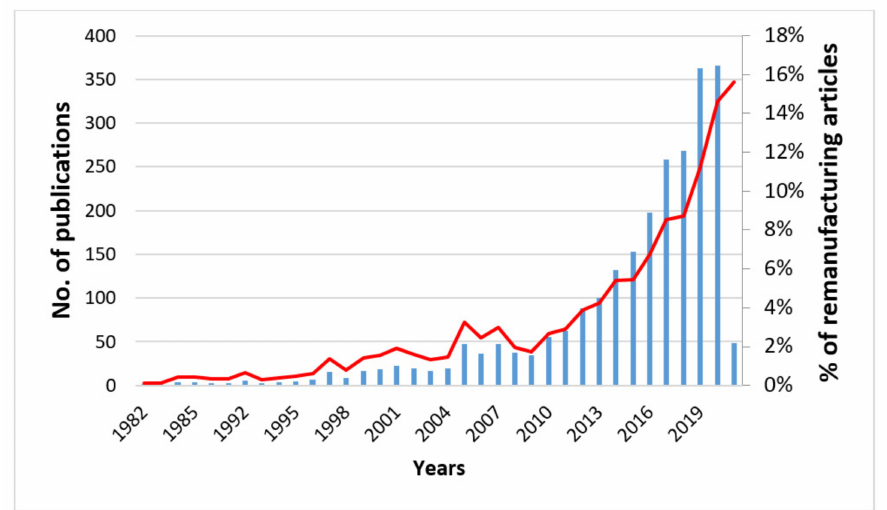
Figure 7. The number of annual publications on remanufacturing. The blue bar indicates the total number of yearly remanufacturing-related papers, and the red line indicates the ratio of yearly remanufacturing-related publications to the total publications in all fields × 1000.